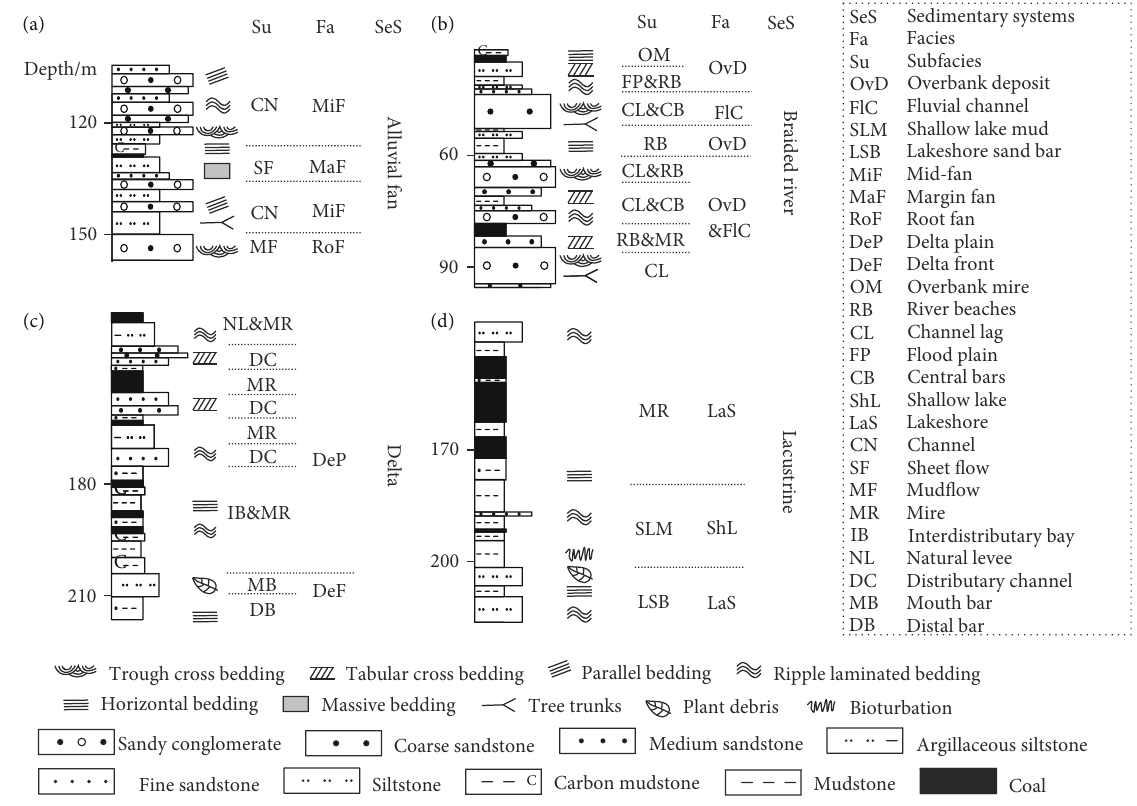
Figure 2: Typical depositional sequence of the middle member of Xishanyao Formation in the western Dananhu coal fi eld: (a) alluvial fan; (b) fl uvial plain; (c) delta; (d)